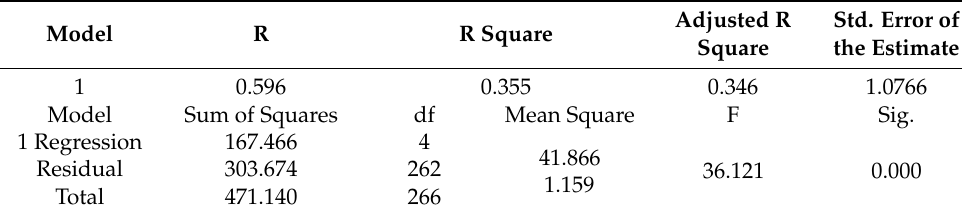
Table 8. R2 test and F-Test.